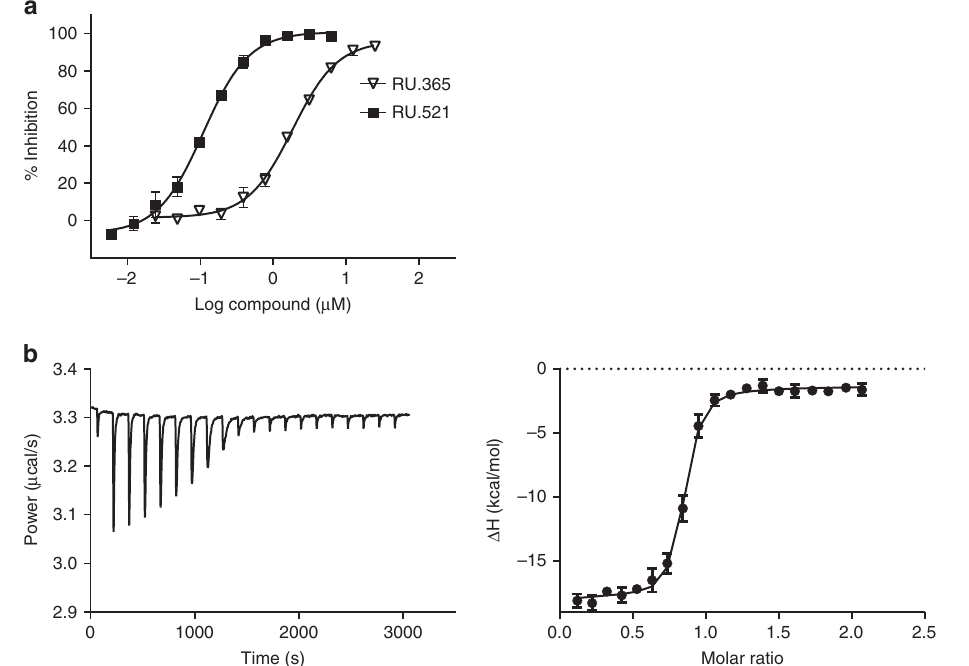
Fig. 4 cGAS inhibition by RU.365 and its chemical active analogs. a In vitro concentration response curves for RU.365 and the most potent analog synthesized in-house, RU.521, in the presence of dsDNA, ATP and GTP as measured by RF-MS. The IC50 values for RU.365, RU.521 and less potent analogs are listed in Supplementary Table 4. Values are averages of triplicate determinations with SD indicated. b Isothermal titration calorimetry-binding curves for RU.521 titrated into cGAS/dsDNA